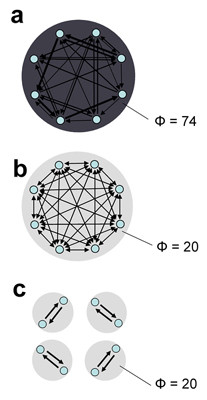
Information integration for a thalamocortical-like architecture. a. Optimization of information integration for a system that is both functionally specialized and functionally integrated. Shown is the causal interaction diagram for a network whose connection matrix was obtained by optimization for Φ (Φ = 74 bits). Note the heterogeneous arrangement of the incoming and outgoing connections: each element is connected to a different subset of elements, with different weights. Further analysis indicates that this network jointly maximizes functional specialization and functional integration among its 8 elements, thereby resembling the anatomical organization of the thalamocortical system [8]. b. Reduction of information integration through loss of specialization. The same amount of connectivity, distributed homogeneously to eliminate functional specialization, yields a complex with much lower values of Φ (Φ = 20 bits). c. Reduction of information integration through loss of integration. The same amount of connectivity, distributed in such a way as to form four independent modules to eliminate functional integration, yields four separate complexes with much lower values of Φ (Φ = 20 bits).